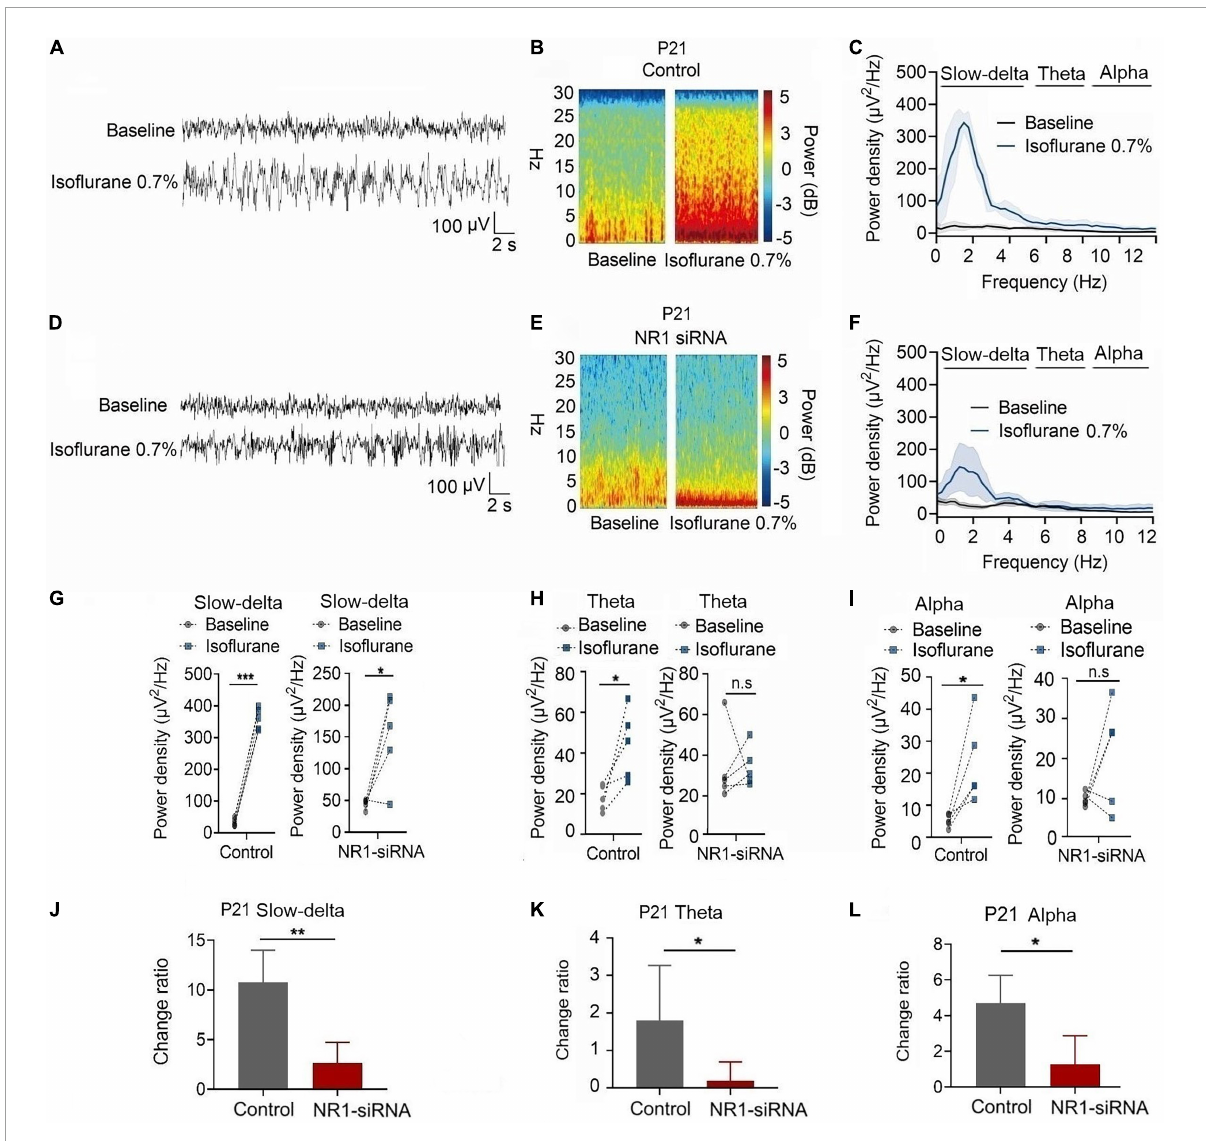
FIGURE7 Knockdown of NR1 inhibited the enhancement of slow-delta, theta and alpha oscillations in P21 rats. (A,B,D,E) EEG and it’s power spectrogram of P21 rats under isoflurane in the control group and NR1-siRNA group. (C,F) EEG power spectral density of P21 rats under isoflurane in the control group and NR1-siRNA group ( n = 5). (G–I) The change of power density of slow-delta, theta and alpha oscillations of P21 rats under isoflurane in the control group and NR1-siRNA group ( n = 5). (J–L) The change ratio of the power density of slow-delta, theta and alpha oscillations of P21 rats under isoflurane ( n = 5). Data are presented as mean ± SD. n.s., not significant; * P < 0.05, ** P < 0.01, *** P < 0.001 by paired t -test (G–I) and unpaired t -test (J–L)